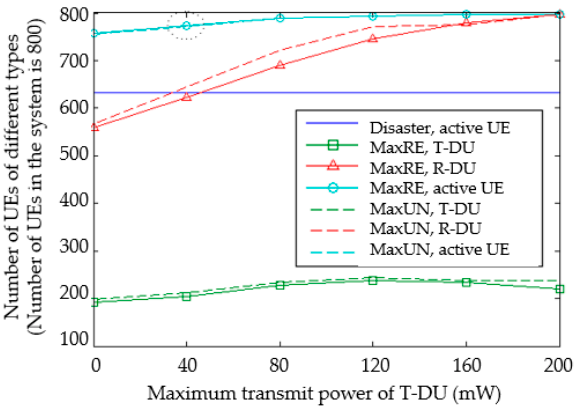
Figure 6. The comparison of UE states under different transmit power.